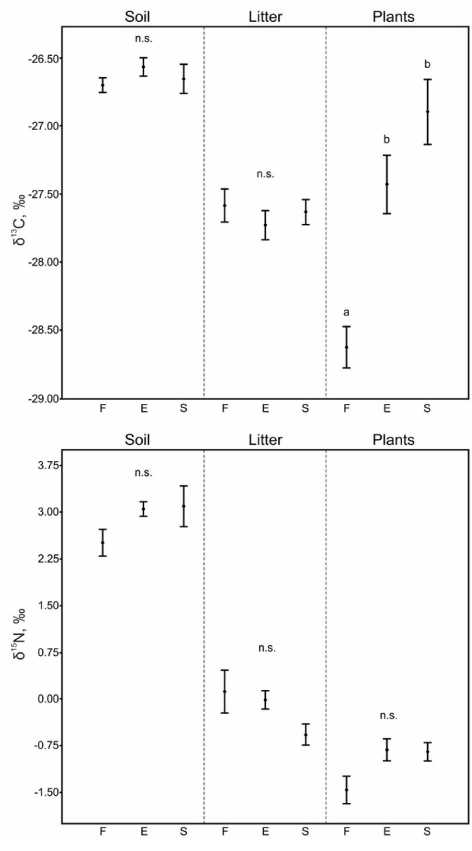
Figure 2. Mean ( ± 1 SE) δ 13 C (top) and δ 15 N (bottom) values of the soil, litter, and green parts of plants in the forest, forest edge, and steppe habitats. Significantly ( p < 0.05) different values are indicated by different letters (a, b). n.s. – no significance. F: forest, E: edge, S: